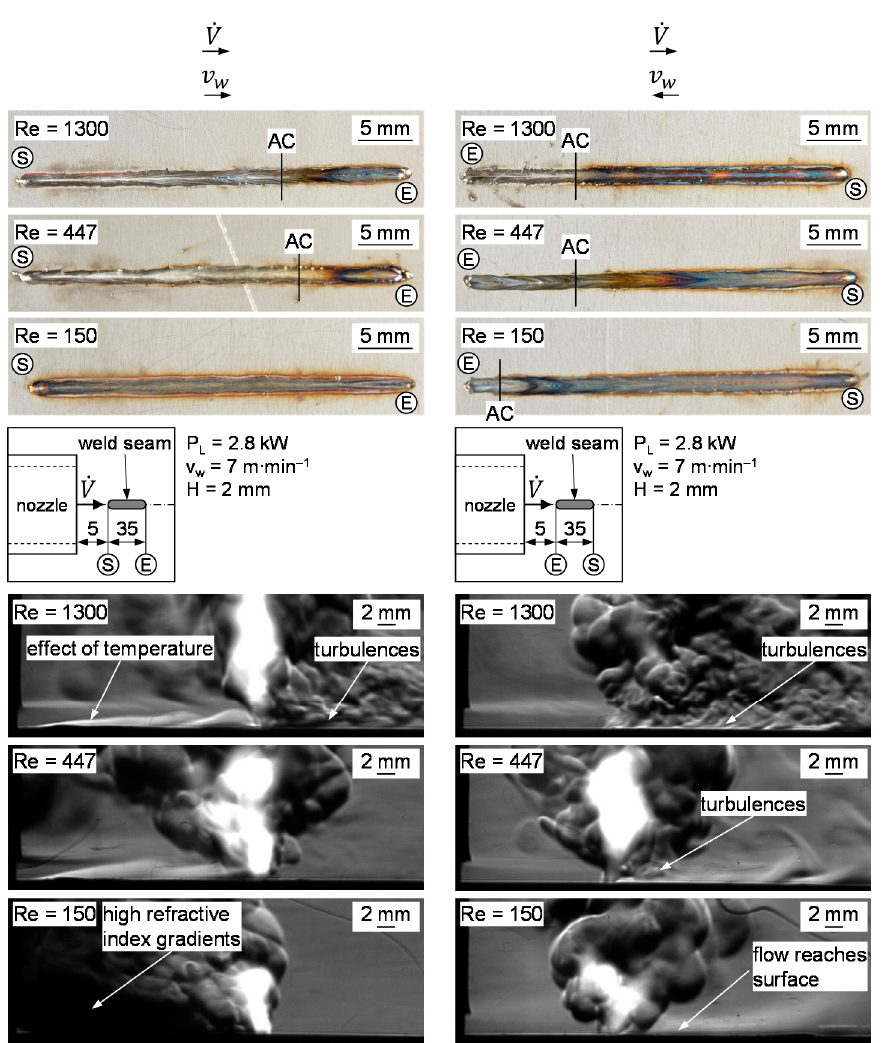
Figure 13. Effect of welding direction on shielding gas coverage and Schlieren images at weld seam center. When the welding direction and flow direction were opposed, generally, shorter areas without tarnishing were found compared to the reversed welding direction.